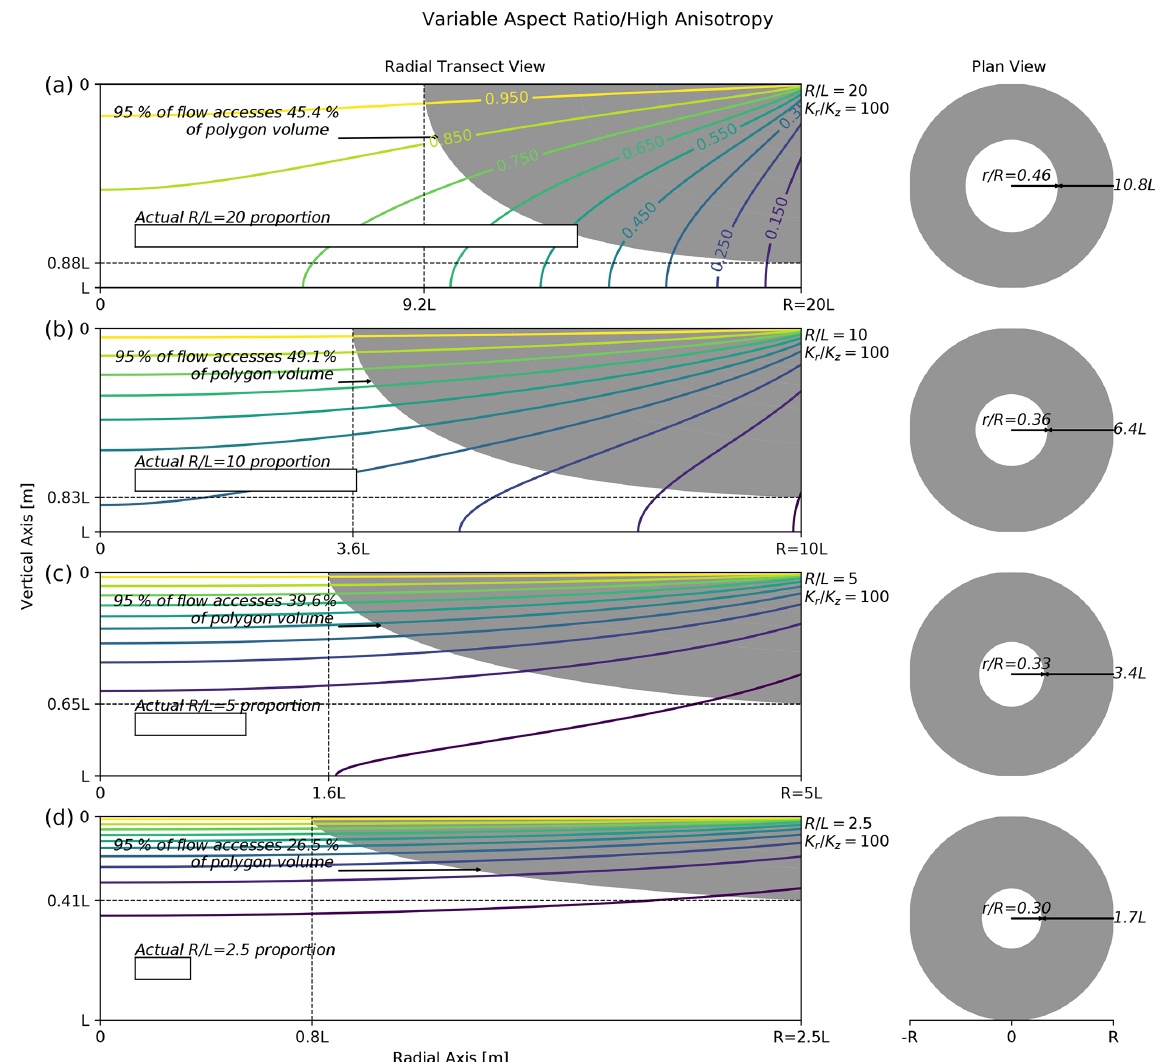
Figure 6. Effect of polygon aspect ratio on polygon drainage with high-hydraulic-conductivity anisotropy coefficient ( K r /K z = 100). Plots along the left contain polygon radial transect head contours (colored lines) and filled stream tubes (gray regions) for several polygon aspect ratios (radius/thickness). The gray shaded region denotes the portion of the transect accessed by 95% of the flow. The plots along the right contain corresponding gray rings indicating the surface area where 95% of the polygon flow infiltrates. Each plot along the left contains a rectangle drawn to the actual proportions for the given polygon aspect ratio. In all cases, the anisotropy coefficient (horizontal conductivity/vertical conductivity) is fixed at